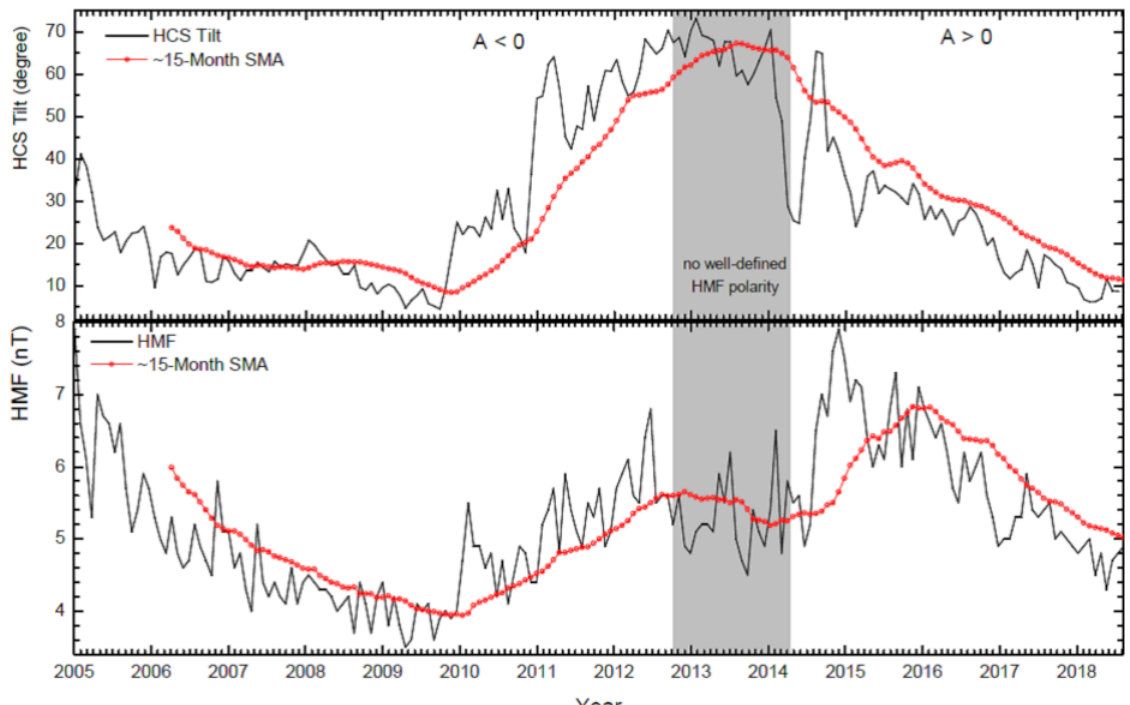
Figure 1. The 27-day averaged values for the heliospheric current sheet (HCS) tilt angle ( top panel; black line) and magnitude of the heliospheric magnetic field (HMF) ( bottom panel; black line) at the Earth from January 2005 to December 2018 along with the calculated 15-month smoothed moving averages (SMA; red dots) as applied in the model. The period with no well-defined HMF polarity is indicated by the shaded band during which the HMF polarity reversal took place changing from A < 0 to A > 0. These entities serve as good proxies for solar activity when it comes to charged cosmic particles.